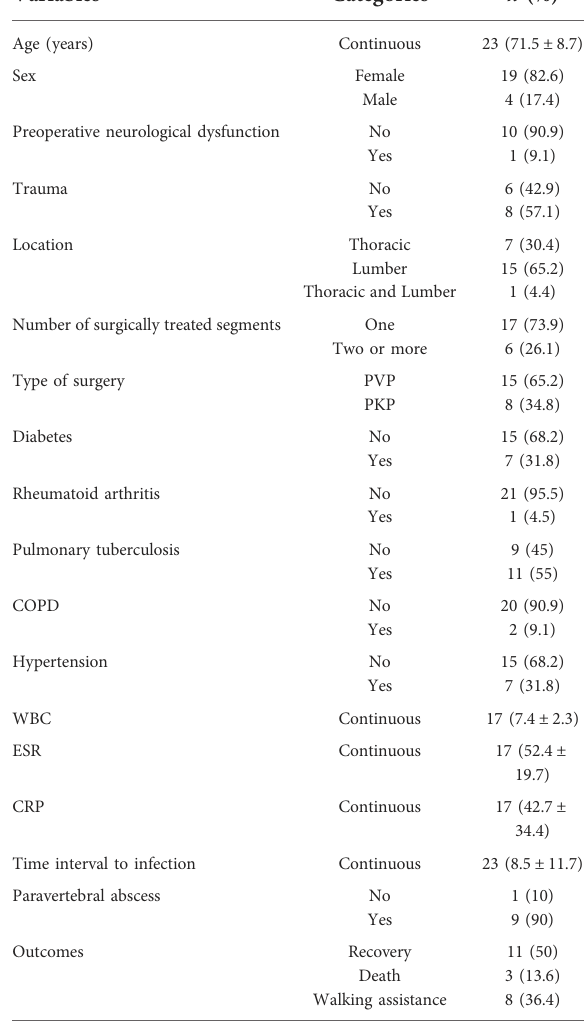
TABLE 1 Summary of the clinical characteristics in TS